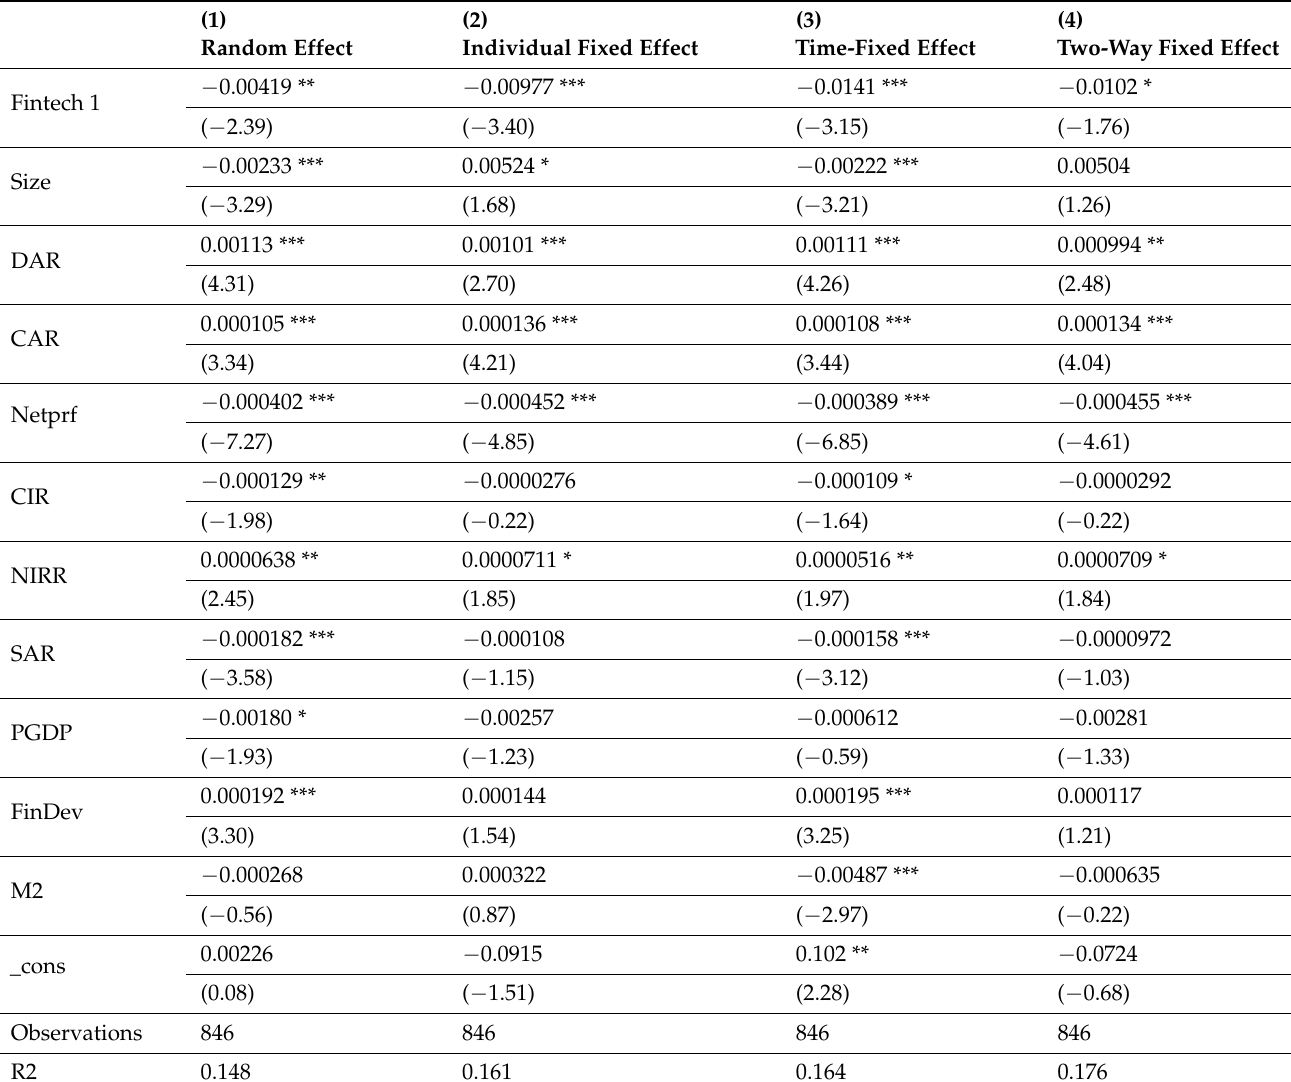
Table 3. Benchmark model regression